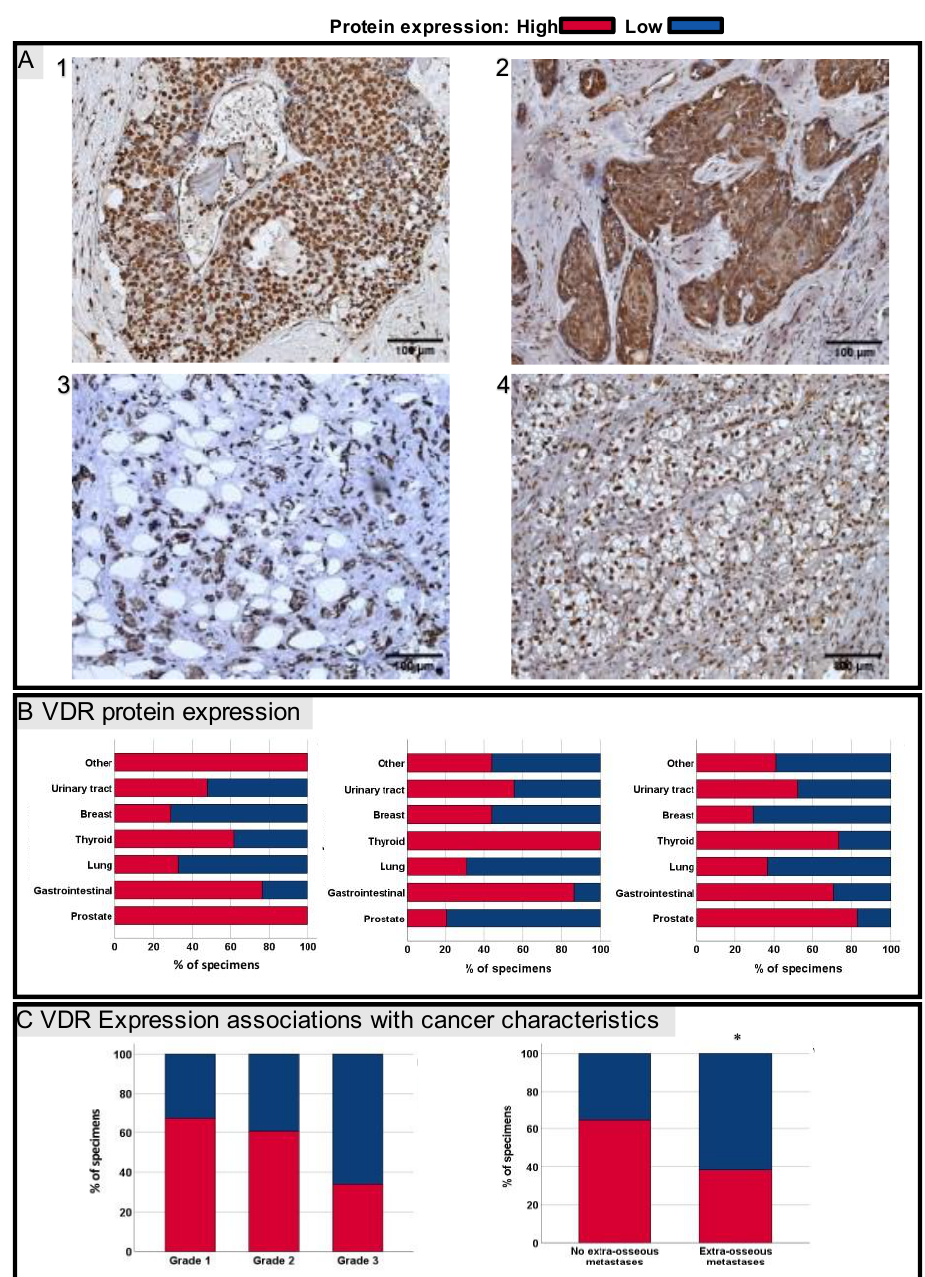
Figure 1. ( A ) Representative images of IHC staining for VDR of bone metastases secondary to prostate (1), oesophagus (2), breast (3) and renal clear cell cancer (4). ( B ) VDR protein expression sorted by primary cancers of bone metastases. Left to right: nucleus, cytoplasm and total VDR protein expression. ( C ) Of the 53 included specimens, 5 were well differentiated, whereas 27 were differentiated as intermediate and 20 as poor. There was a non-significant trend in high-grade cancers towards low nuclear VDR expressions ( p = 0.07). Additionally, patients with further extra-osseous metastases (multiple metastatic cancers) had reduced nuclear VDR levels compared to patients without other distant metastases ( p = 0.03); red — high VDR protein expression; blue — low VDR protein expression. Scale bar = 100 µm. * p > 0.05.